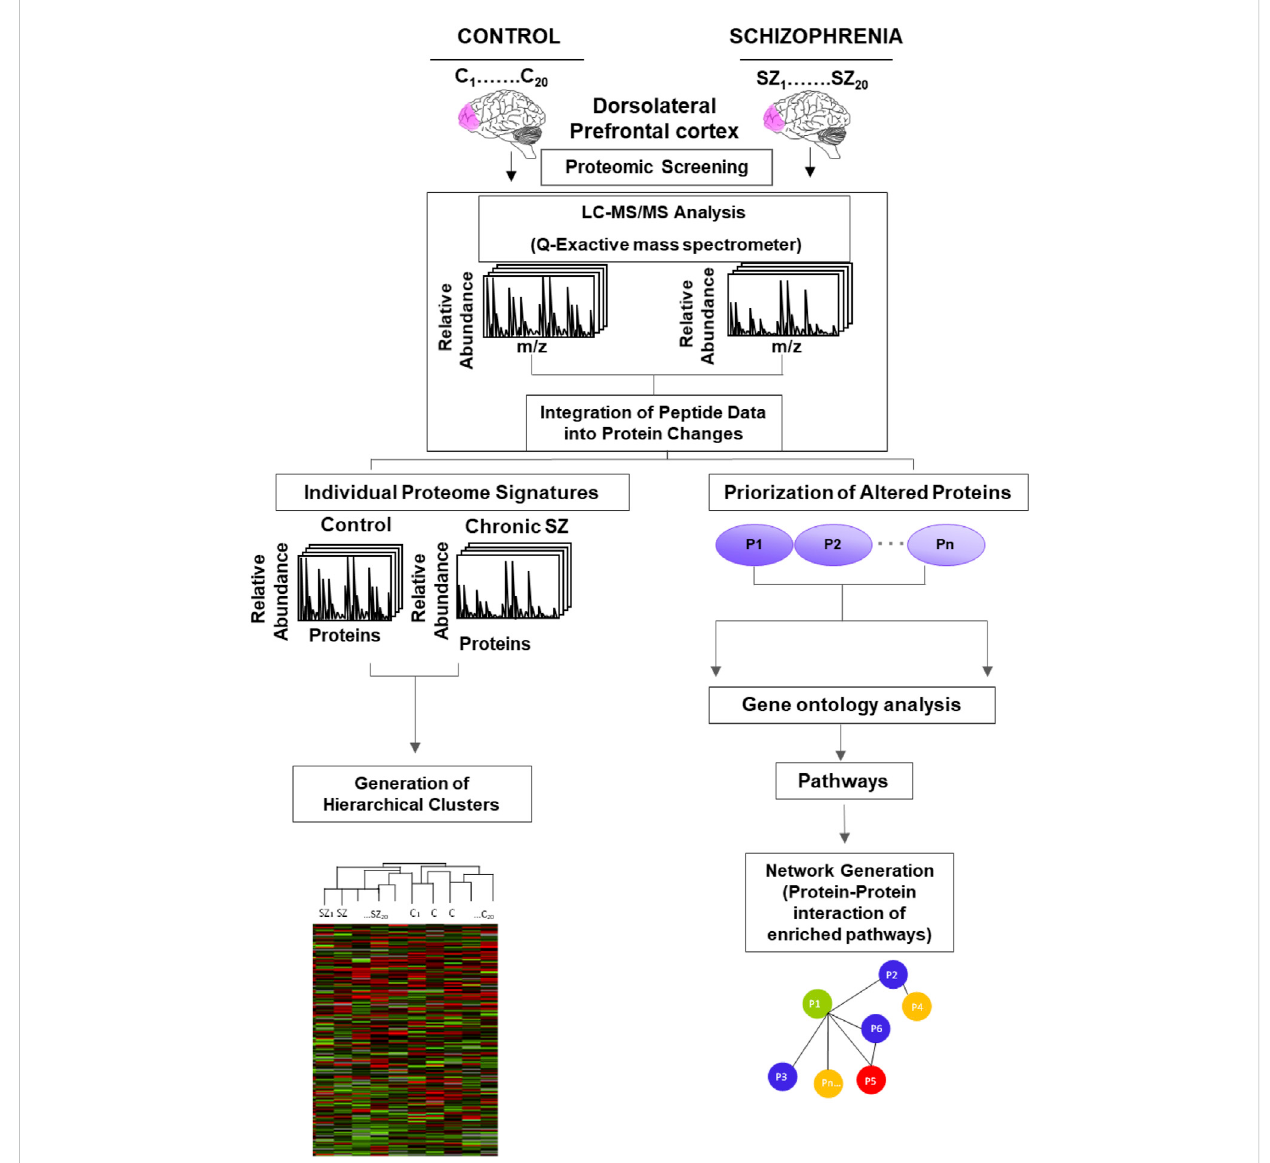
Experimental design of the proteomic analysis to identify altered pathways in schizophrenia. Protein lysates from the postmortem dorsolateral prefrontal cortex of control subjects (C) (n = 20) and chronic schizophrenia (SZ) patients (n = 20) were processed as depicted. The peptides were separated and analyzed by Liquid Chromatography (LC) coupled to a Q-Exactive Orbitrap tandem mass spectrometer. The relative fold change of peptides was integrated into protein changes. The individual protein signatures for each case and control were used to generate hierarchical clusters. The prioritization of altered proteins (P1-Pn represents generic proteins) in SZ was obtained by comparing protein fold changes between C and SZ groups (signi fi cant proteins adjusted to an FDR <